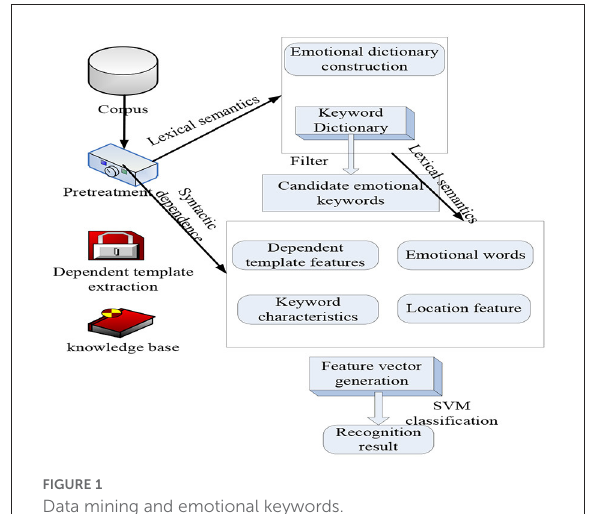
FIGURE1 Data mining and emotional keywords.